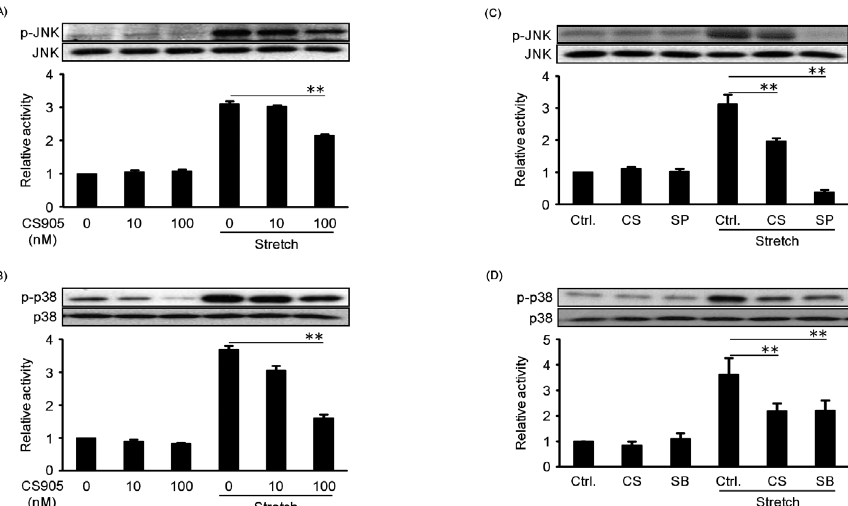
Figure 3. Effects of different concentrations of azelnidipine on the activation of JNK (A) and p38 (B) induced by cyclic mechanical stretch in RASMCs; and the comparison of the effects of azelnidipine and MAP kinase inhibitors on the activation of JNK (C) and p38 (D) induced by cyclic mechanical stretch in RASMCs. The cells were pre-incubated by CS905 (10 nM, 100 nM), SP600125 (20 m M), and SB203580 (20 m M) for 20 min prior to exposing to cyclic mechanical stretch by 15% elongation for 10 min. The phosphorylation of JNK and p38 were measured as described under Materials and Methods . Azelnidipine (CS905), SP600125, and SB203580 are abbreviated as CS, SP, and SB. Densitometric analysis of each value was normalized by arbitrarily setting the densitometric value of the control cells (Ctrl.) to 1. Each value represents the mean 6 S.D. (n=3). The asterisks represent significant differences compared with the stretched control value (* P , 0.05, ** P , 0.01).